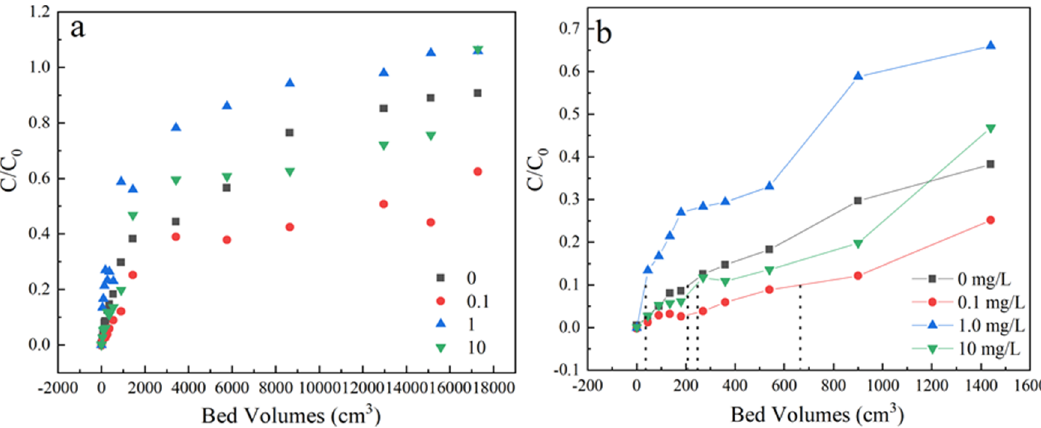
Figure 6. ( a ) The adsorption effect of different concentration of human acids on breakthrough curves, ( b ) Partially enlarged screening from 0 to 1600 bed volume. Experiment condition: flow rate of 3 mL/min, column height of 3 cm, sulfamethoxazole concentration of 35 mg/L, pH 6.5, humic acids concentration= 0, 0.1, 1, 10 mg/L, respectively.